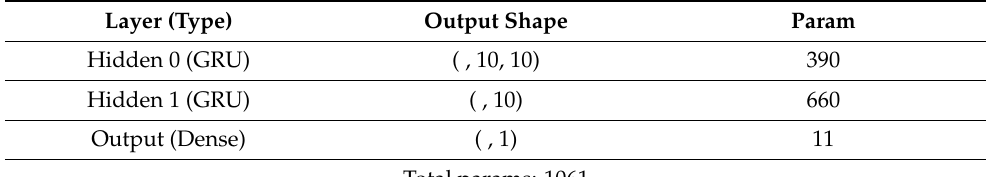
Table 2. Number of nodes in each hidden layer